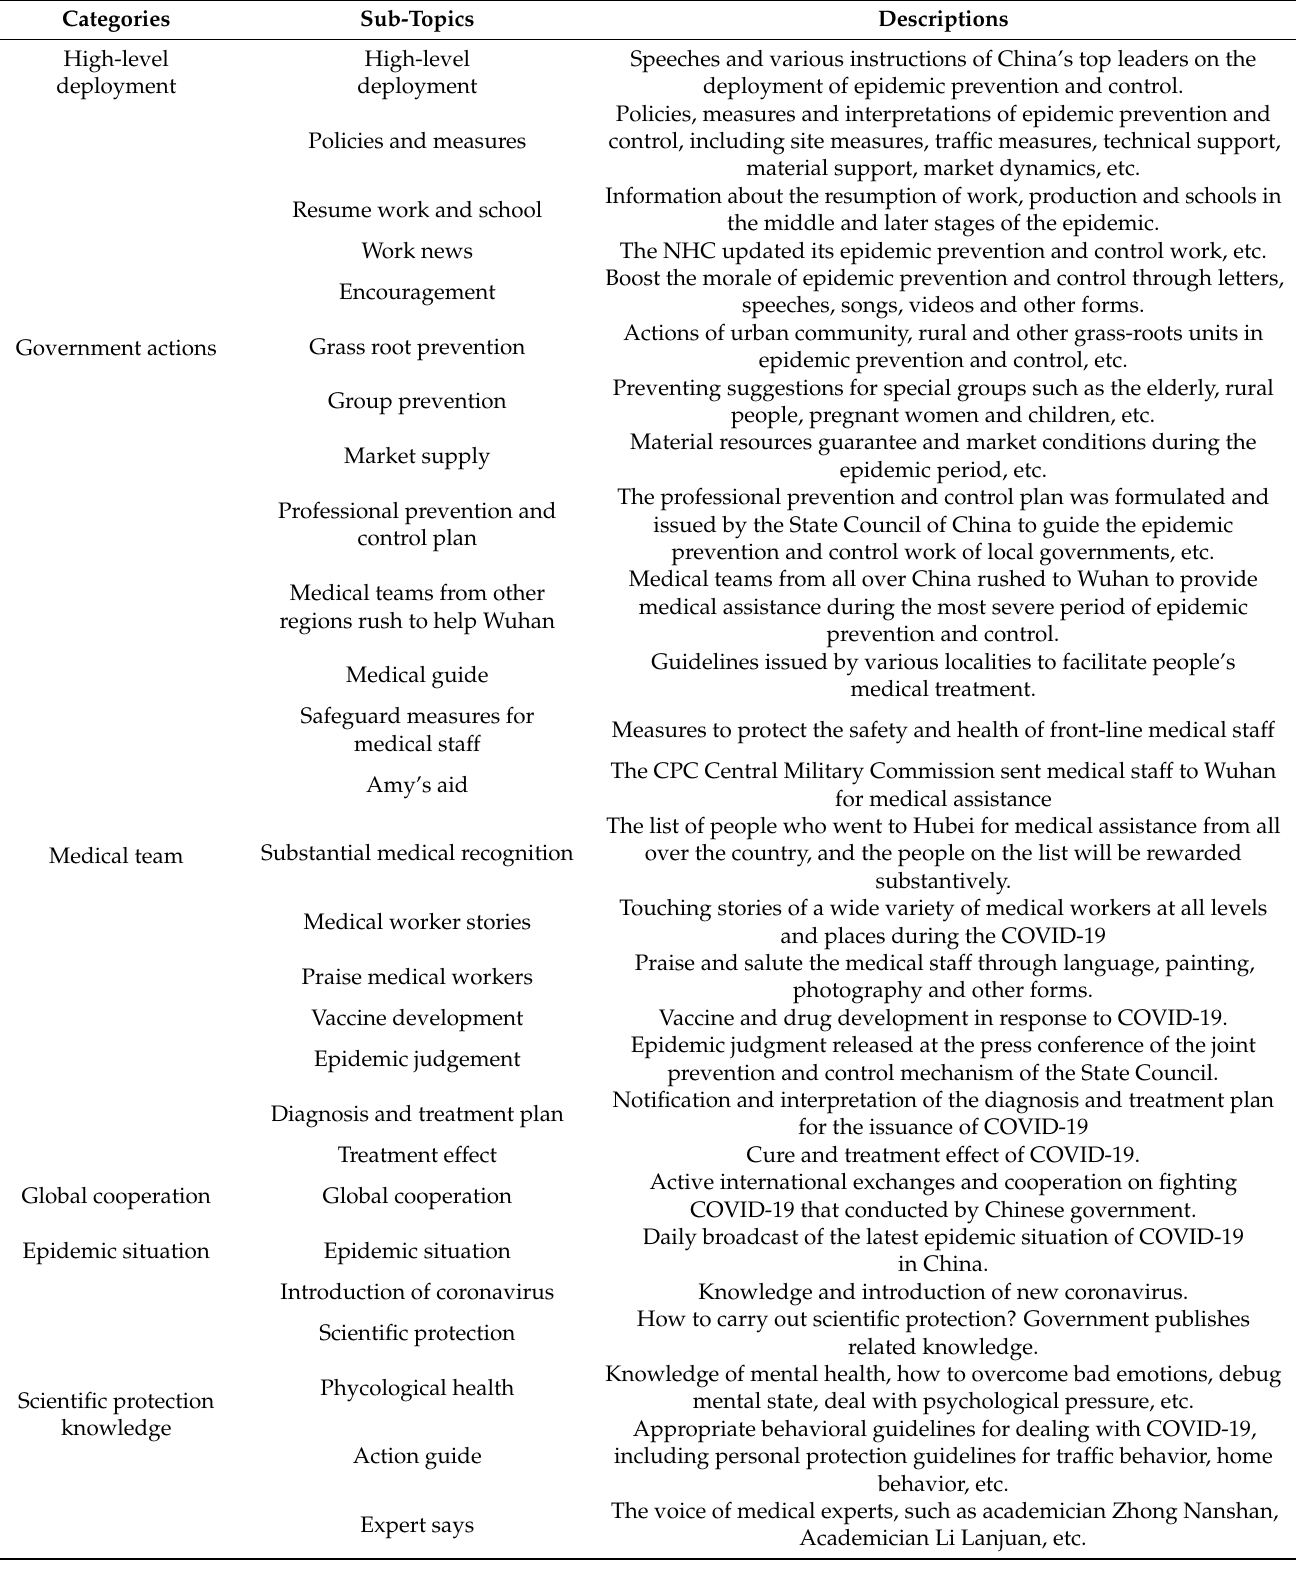
Table A1. Text Coding Results of Government